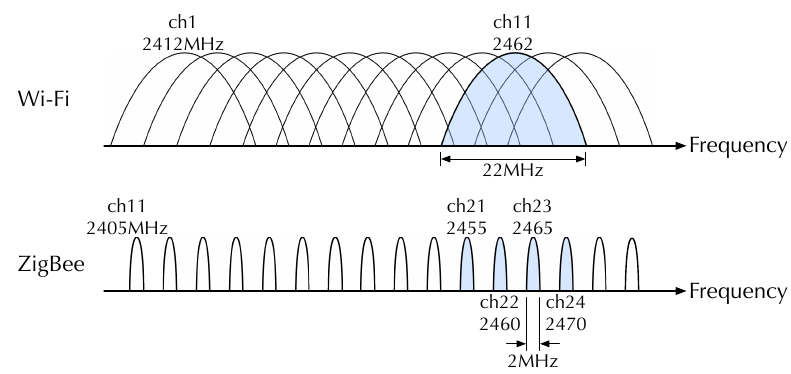
Figure 1. Channel coordination of Wi-Fi and ZigBee.